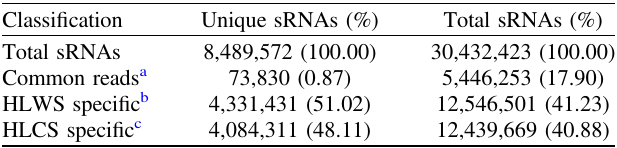
Table 2. Common and taxon-speci fi c reads of HLWS and HLCS.